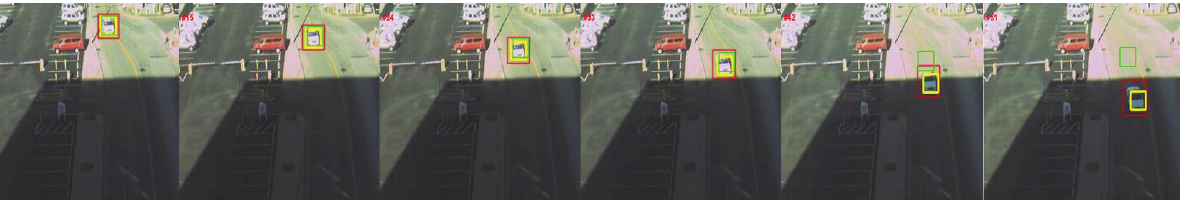
Figure 8: Tracking results of car sequence . Frames 6, 15, 24, 33, 42, and 51 are displayed.